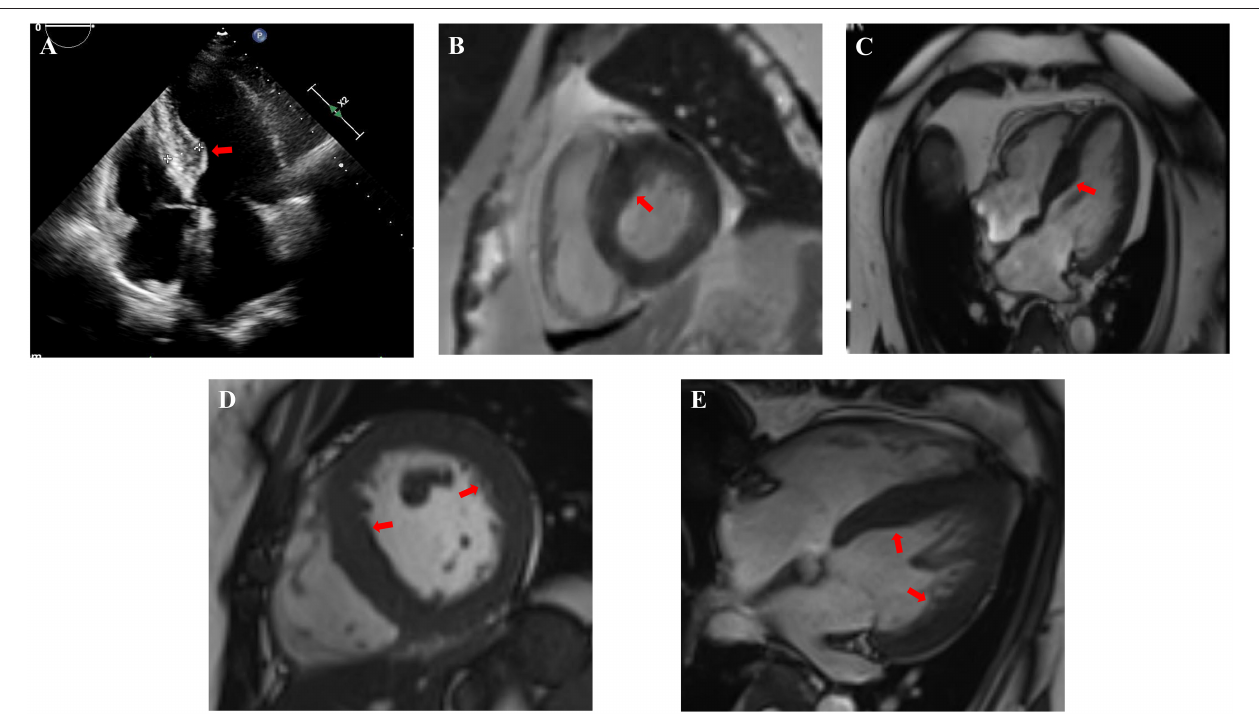
FIGURE 1 | Cardiac images indicated non-uniformly thickened ventricular walls and hypertrophic cardiomyopathy of Case 2 (A–C) and Case 3 (D,E) . (A) Echocardiogram in Case 2 showed significant thickening of the base of the interventricular septum. (B,C) Cardiac MRI in Case 2 showed the lateral wall of the left ventricle was about 8–10mm and the thickening of the basal and intermediate segments of the interventricular septum was uneven with the thickest part about 20–22mm (red arrow). (D,E) Cardiac MRI in Case 3 showed the lateral wall of the left ventricle was about 9–11mm and the interventricular septum thickened, about 14–16mm. The red arrows indicate non-uniformly thickened ventricular wall.